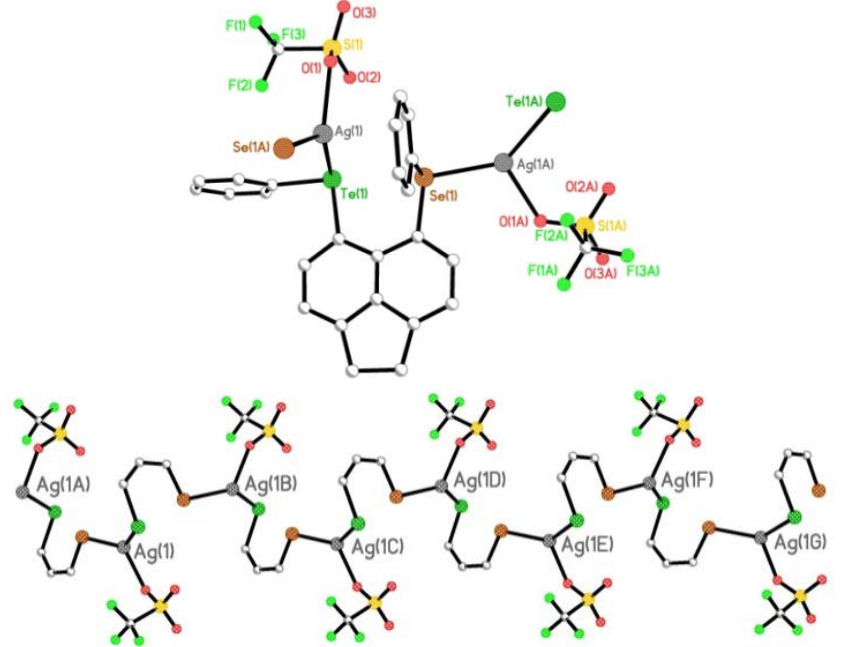
Figure 10. The repeating unit of extended helical chain polymer 6 ( top ; H atoms and solvent molecules omitted for clarity) and the central core of the repeating unit showing the three coordinate, trigonal planar silver(I) geometry ( bottom ).